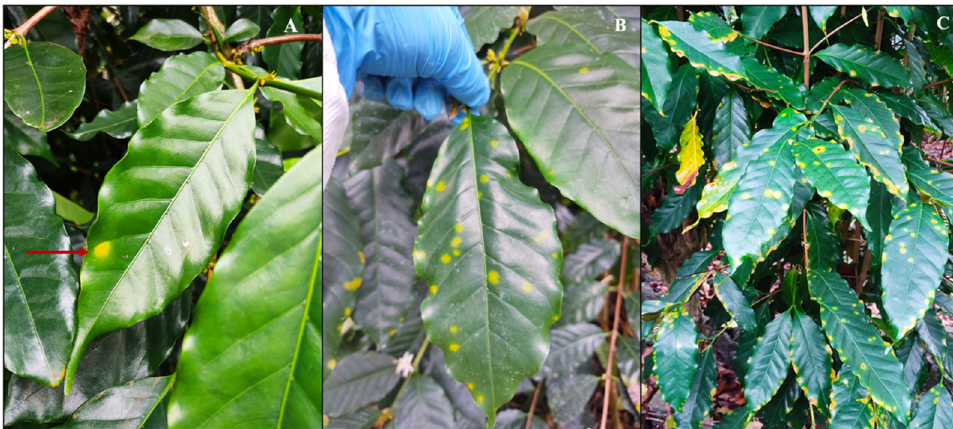
Figure 2. Symptoms of CLR infection on the upper leaf surface: initial infection with a single yellow lesion ( A ); as the disease progresses multiple lesions appear ( B ); advanced infection with many yellow lesions and tissue necrosis ( C ). Photos by Luis F. Aristizábal.